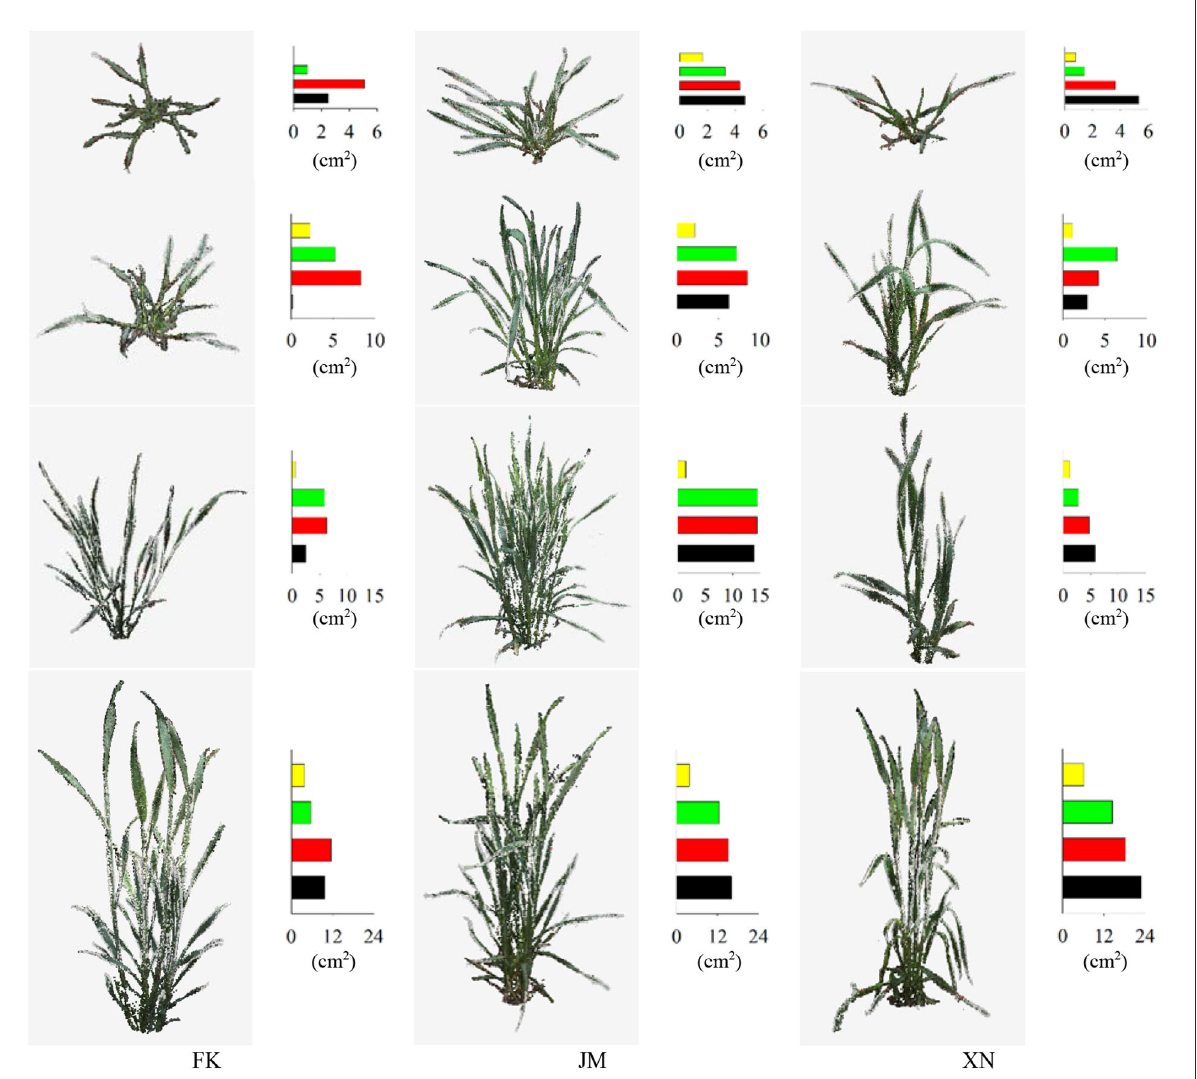
FIGURE10 Point cloud visualization of reconstructed wheat shoots of three cultivars at four growth stages. Bar charts represent projected leaf area (cm 2 ) in four layers. The colors, black to yellow, indicate layered projected area from bottom-to-top